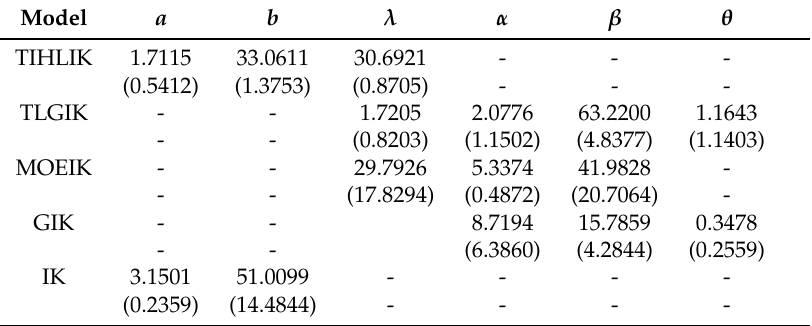
Table 8. MLEs along with their standard errors (in parentheses) for data set 2.